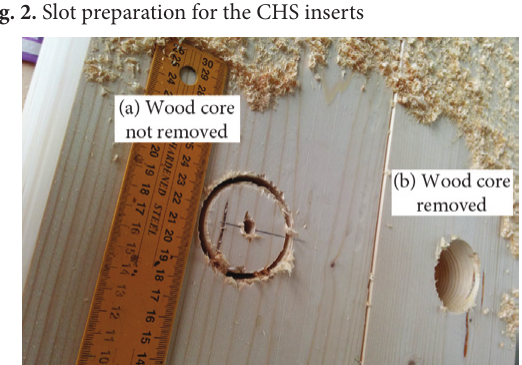
Fig. 2. Slot preparation for the CHS inserts